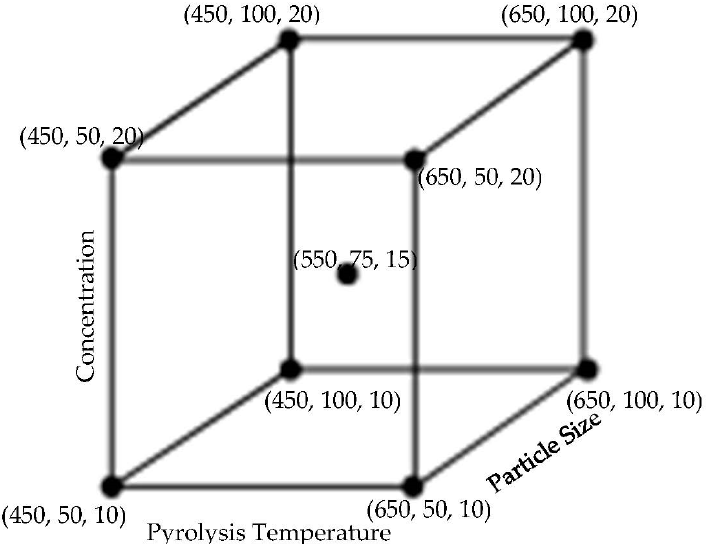
Figure 21. Schematic diagram of the Design of Experiments where the nodes represent the biocarbon characteristics in the order of (temperature in ◦ C, particle size in microns, and particle concentration in percentage).